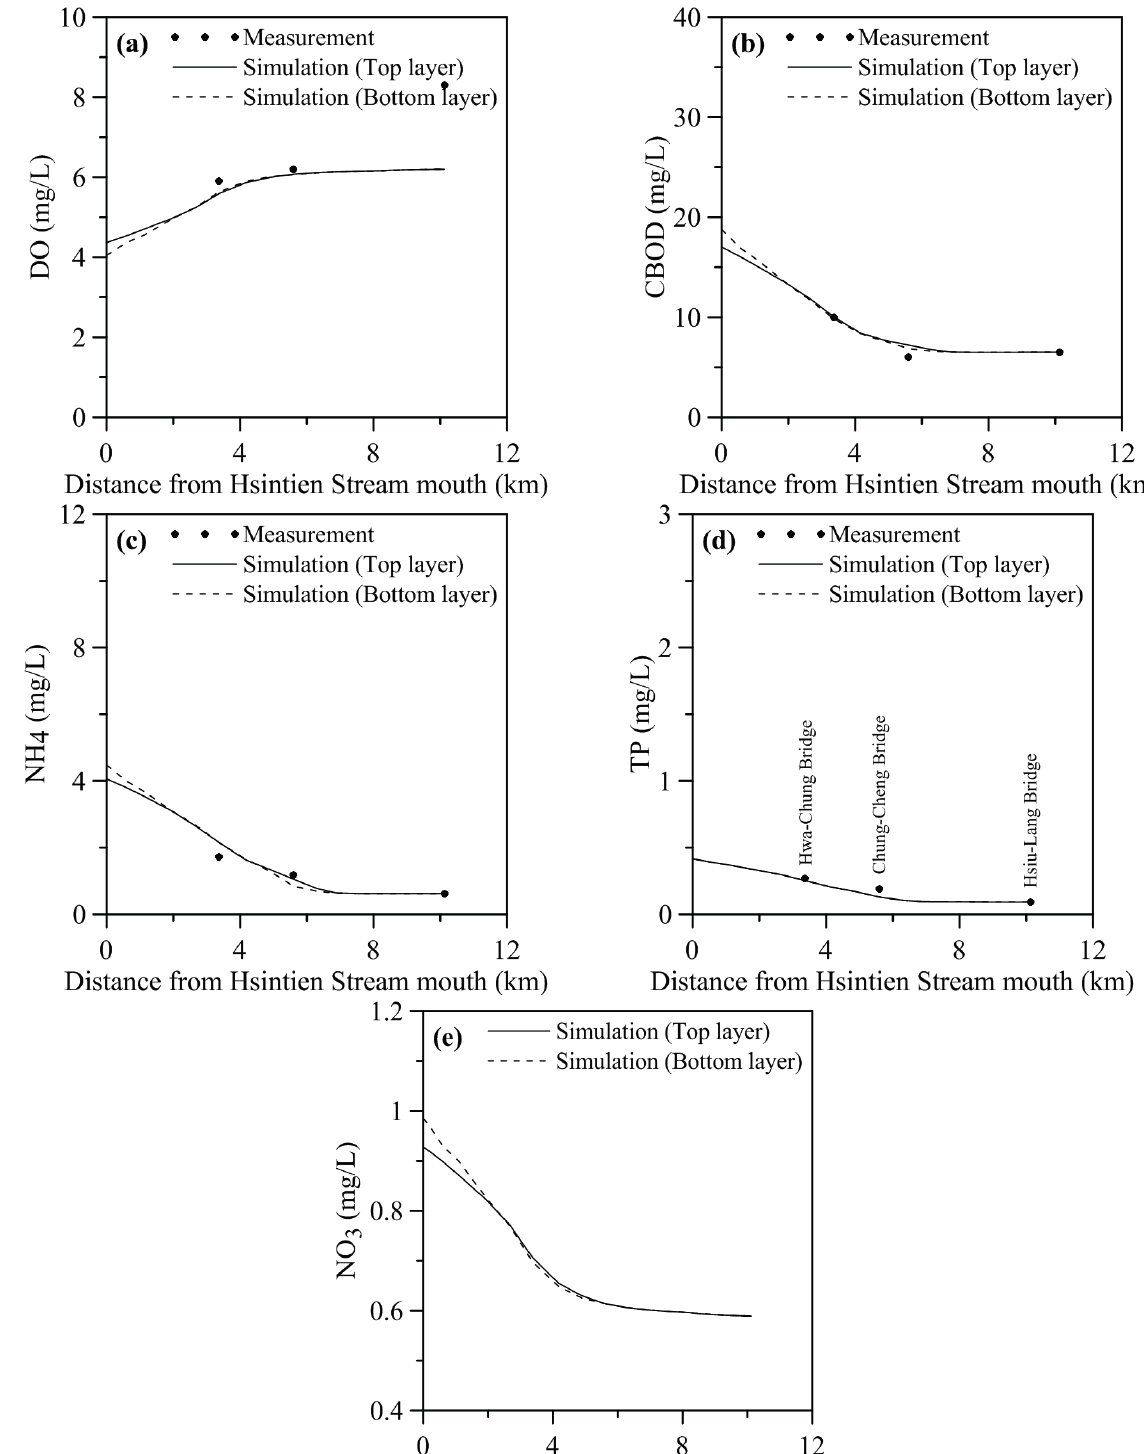
; ( d ) TP; and ( e ) NO 4 3 3